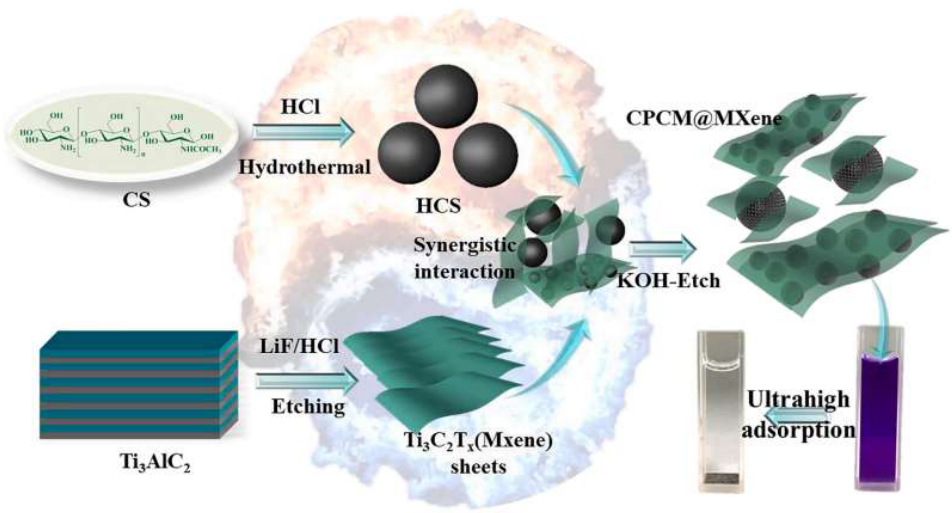
Figure 4. Schematic representation of the assembly of hydrothermal carbon spheres (HCS) from chitosan (CS) and Ti 3 C 2 T x MXene. Reproduced with permission from Wu et al., Chem. Eng. J. 2021, 426, 130776 , published by Elsevier [93].